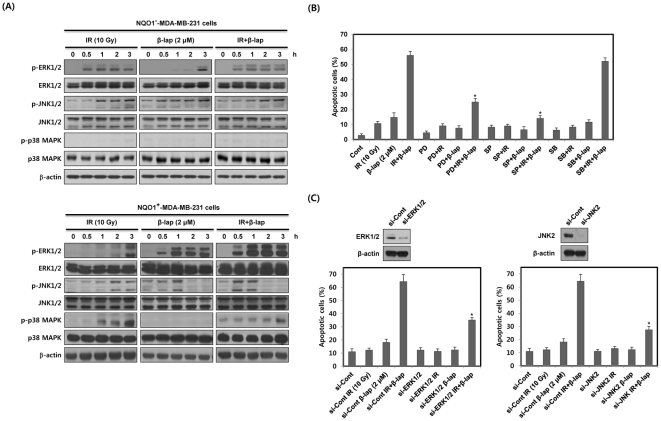
β-lap in combination with IR rapidly activates ERK and JNK.(A) NQO1− or NQO1+-MDA-MB-231 cells were treated with IR alone, β-lap alone or combination of IR and β-lap for the indicated times. The data represent a typical experiment conducted three times with similar results. (B) and (C) NQO1+-MDA-MB-231 cells were treated with IR alone, β-lap alone or combination of IR and β-lap for 24 h in the presence or absence of PD98059 (30 µM), SP600125 (30 µM), SB203580 (30 µM), or siRNA targeting ERK1/2 or JNK2. The percentage of cells with sub-G1 DNA content was determined by flow cytometry. Results from three independent experiments are expressed as means ± SEMs.